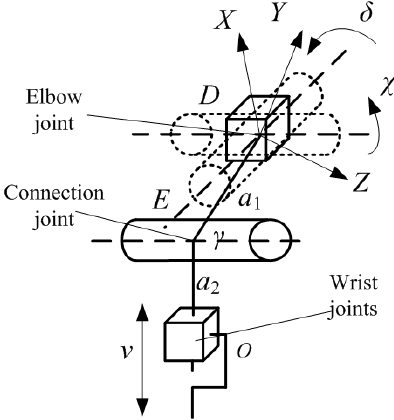
Figure 5. Robot forearm motion model.